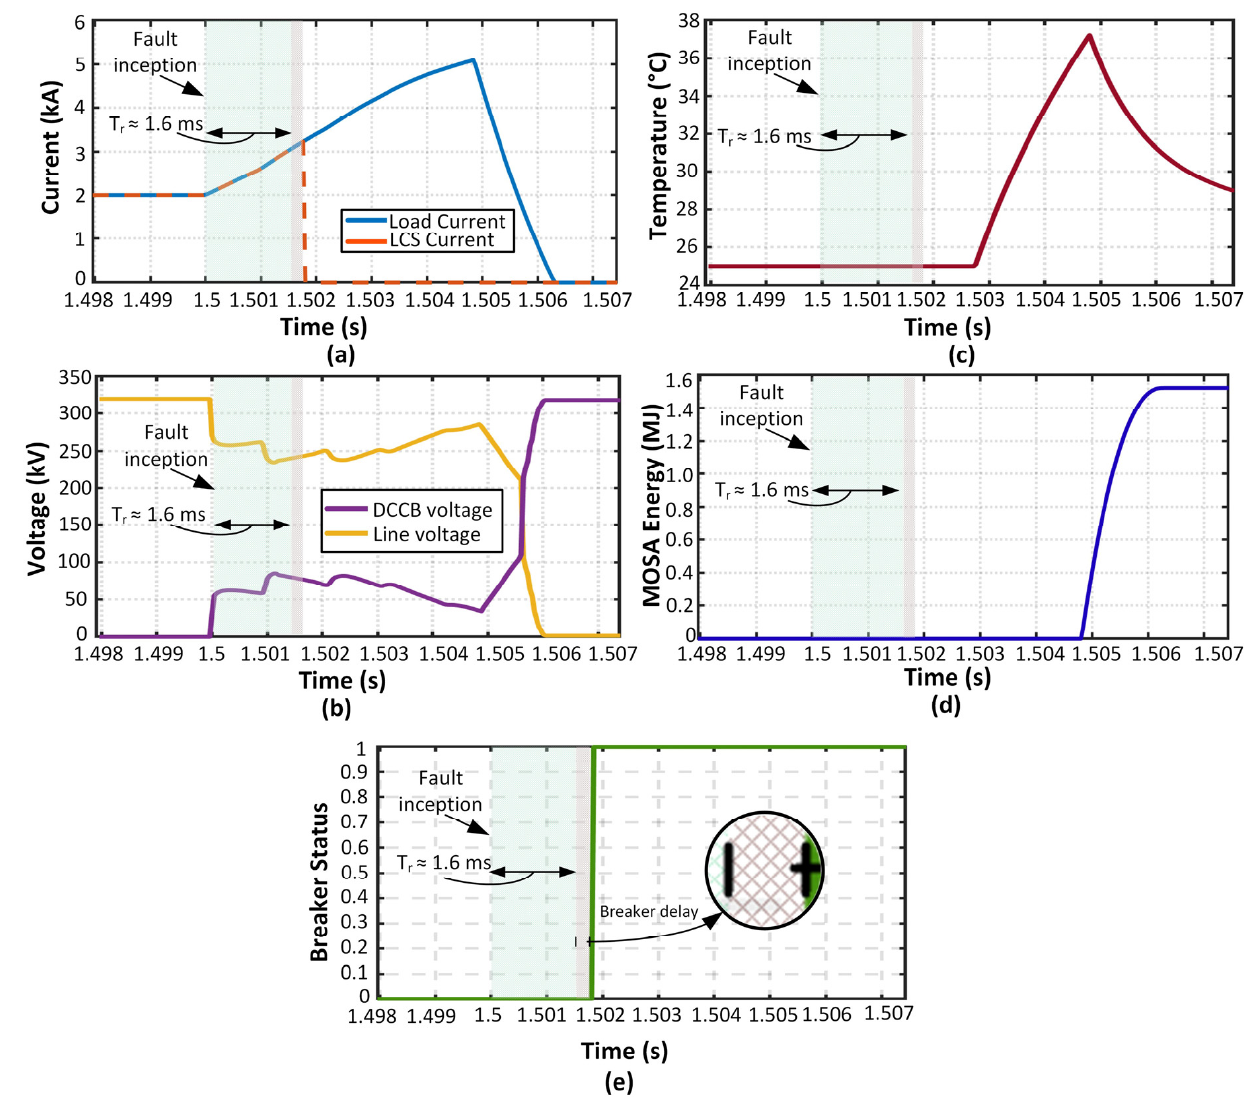
Figure 14. Fault current interruption under 1.5 ms time window ( a ) DC fault current, ( b ) Line and DCCB voltage, ( c ) IGBT valve temperature, ( d ) MOSA energy absorption, ( e ) Breaker Status.